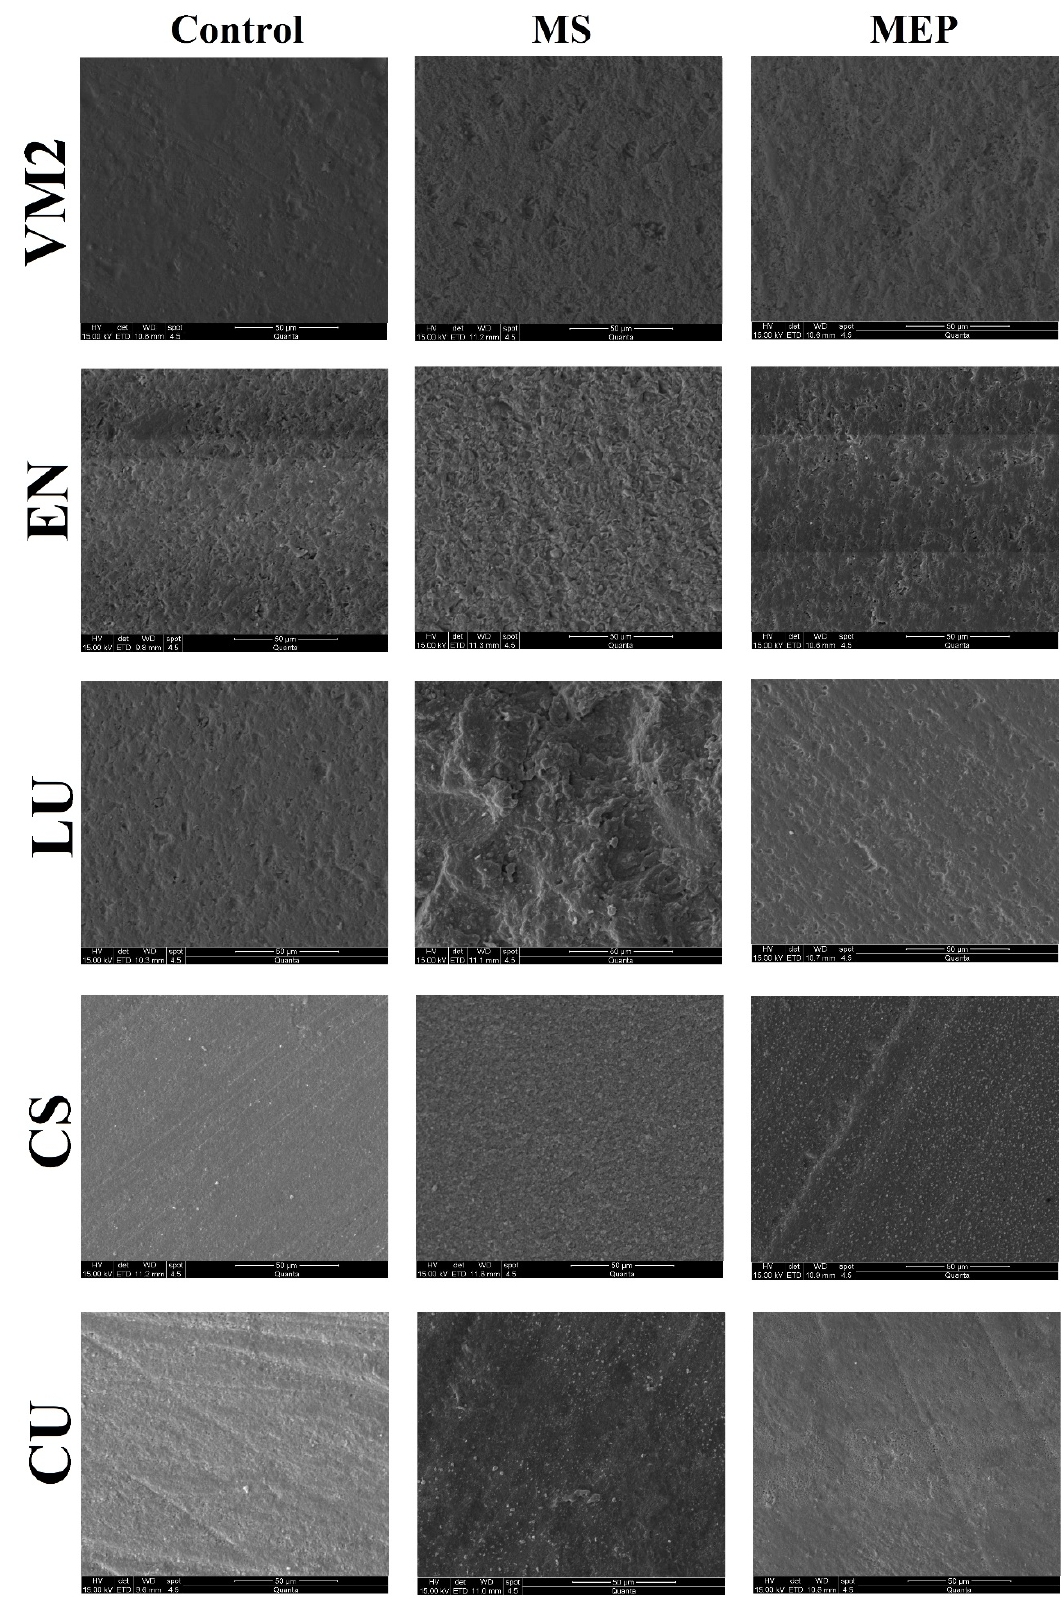
Figure 4. Scanning electron microscopy (SEM) micrographs of the study materials following surface treatment.